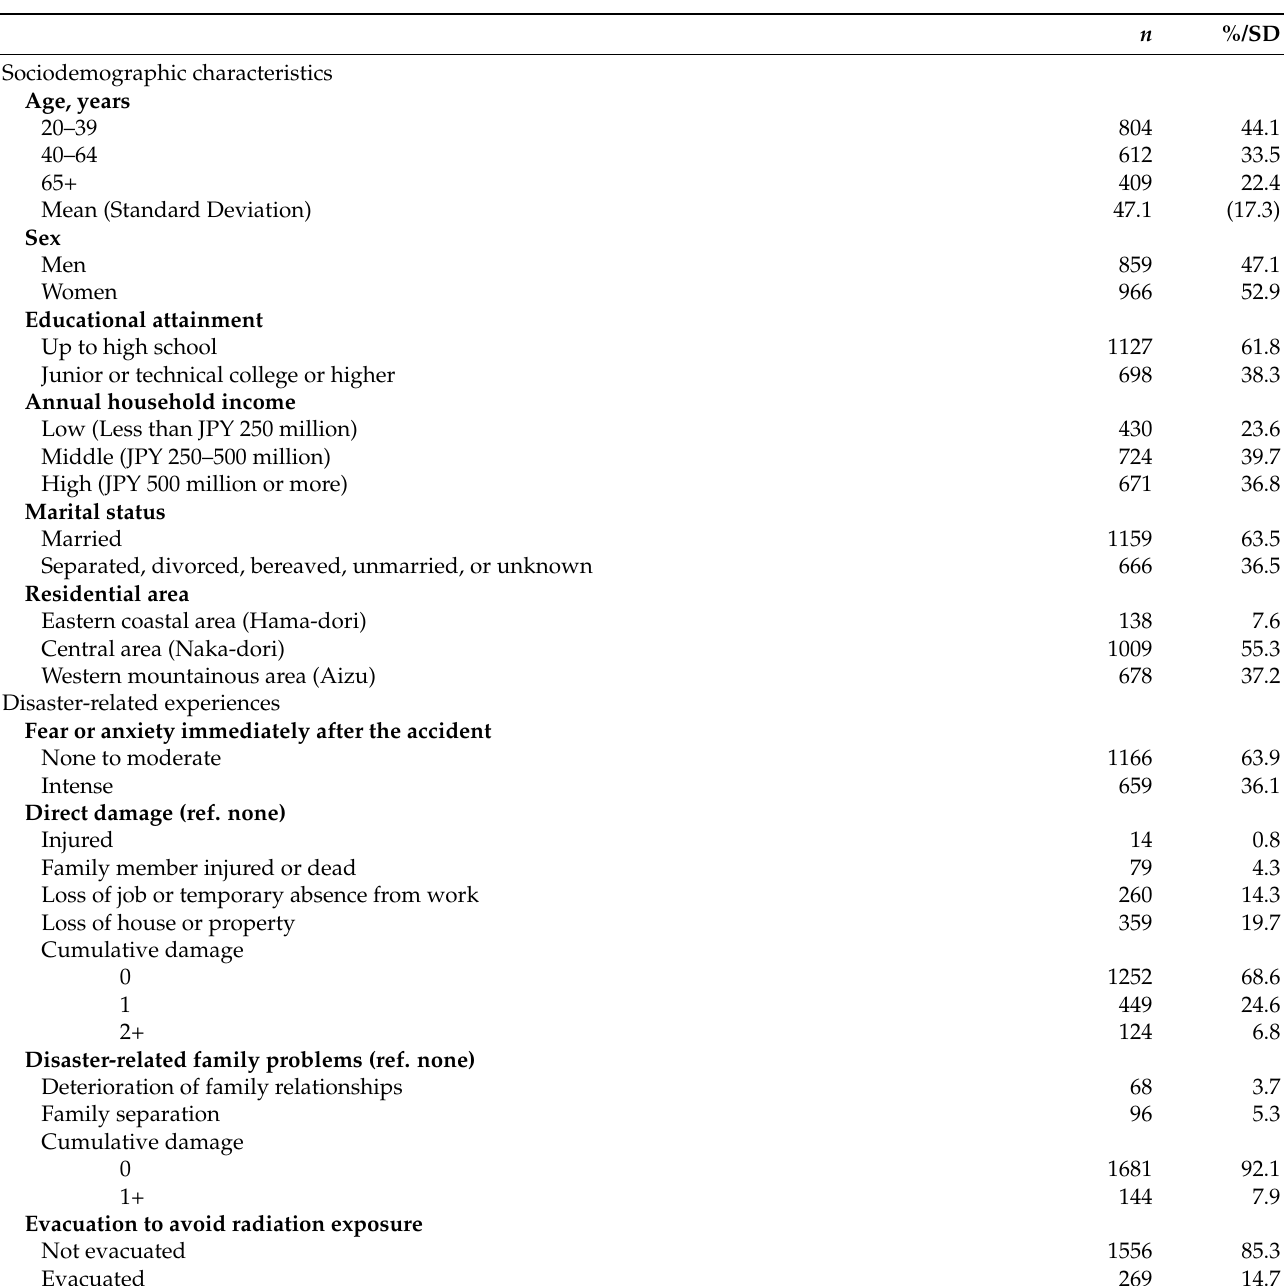
Table 1. Characteristics of the participants in the baseline survey conducted five years after the Fukushima nuclear power plant accident. ( n =